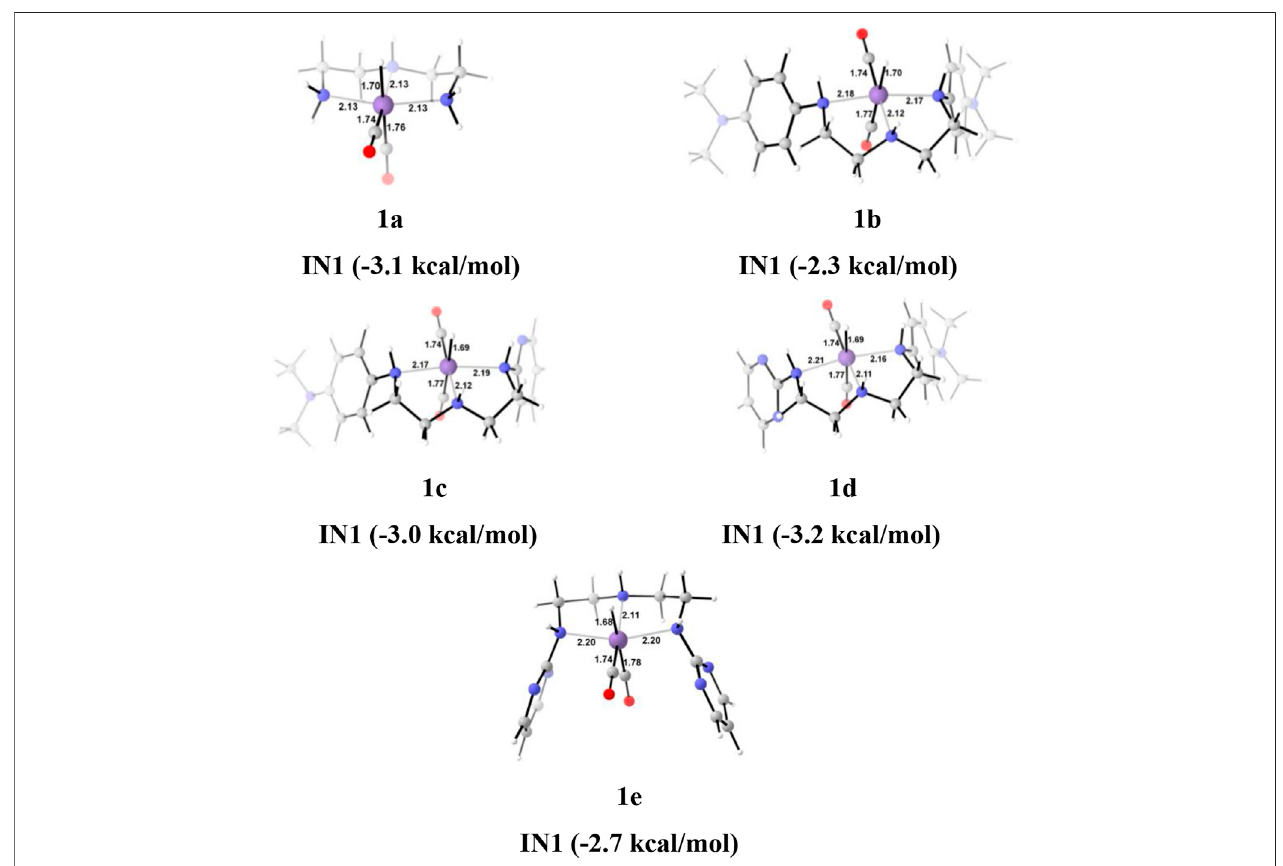
FIGURE 6 | The optimized geometries of the Group 1IN1 catalysts. The bond lengths are in Å, and relative Gibbs free energies are in parentheses (The optimized geometries of all the transition states and intermediates are disclosed in Supplementary Data Sheet S1 ).